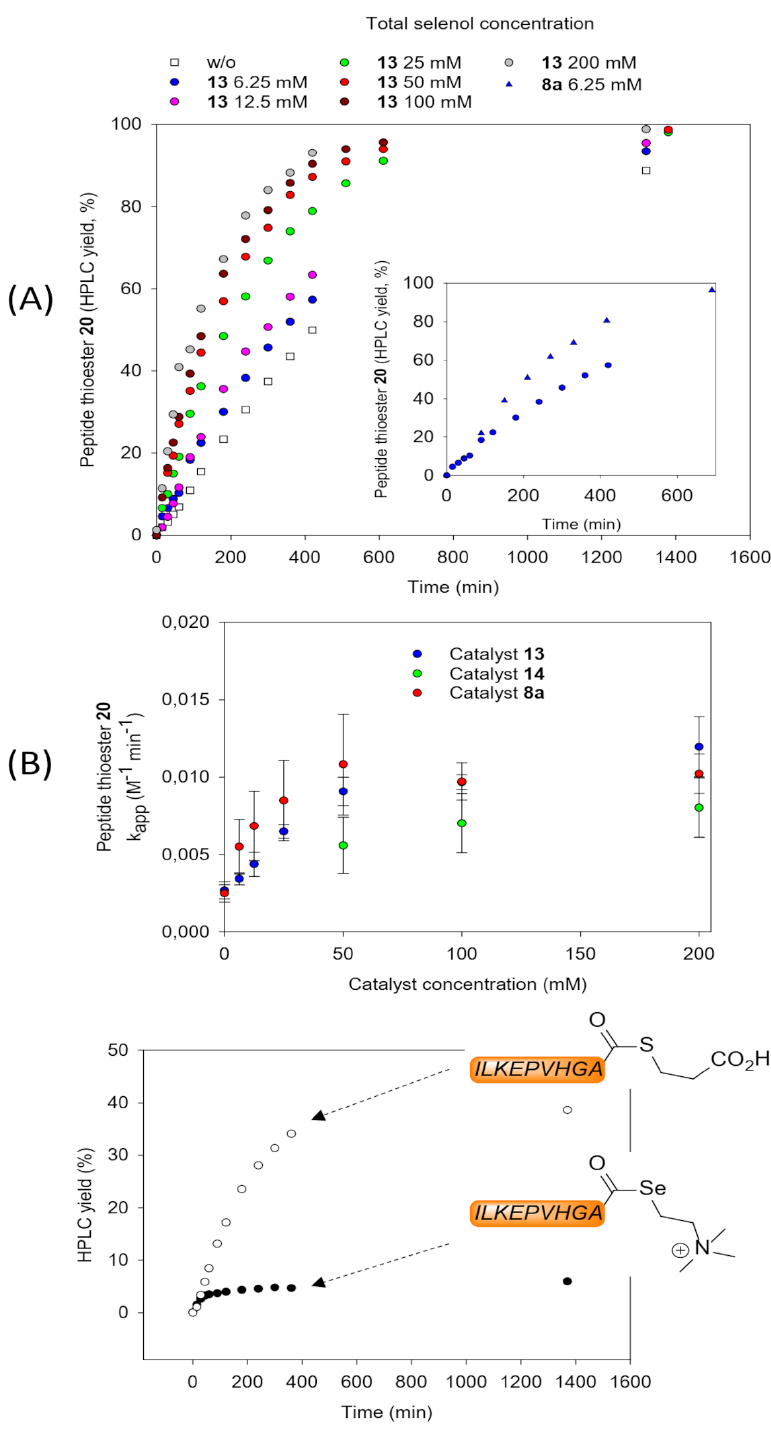
Figure 4. Study of the SEA/thiol exchange reaction catalyzed by selenols 8a or 13 . Conditions: SEA peptide = 1 mM, 37 ◦ C under inert atmosphere, 6 M Gn · HCl, MPA 5% v / v , 100 mM tris (2- carboxyethyl)phosphine hydrochloride (TCEP · HCl), pH 4.0. ( A ) Experimental data as obtained by HPLC monitoring. ( B ) Apparent second-order rate constants obtained by fitting experimental data. The error bars correspond to the standard error of the fit. ( C ) Kinetic profile in the presence of catalyst 14 (200